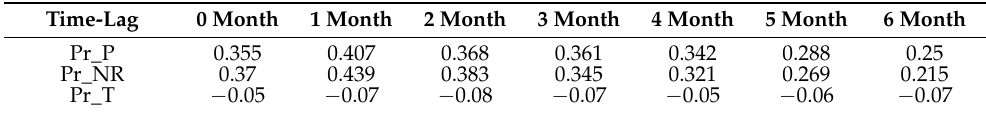
Table 3. Changes in the partial correlation coefficient of NDVI and precipitation/air tempera- ture/surface net radiation (represented by Pr_P, Pr_NR and Pr_T, respectively) under different time-lag conditions.